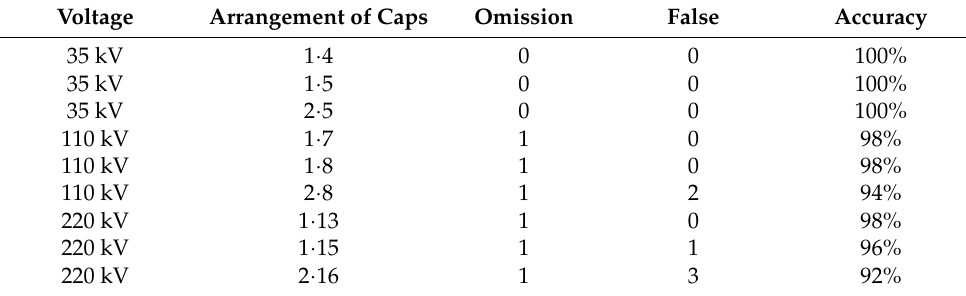
Table 3. Comparison with other target detection methods.